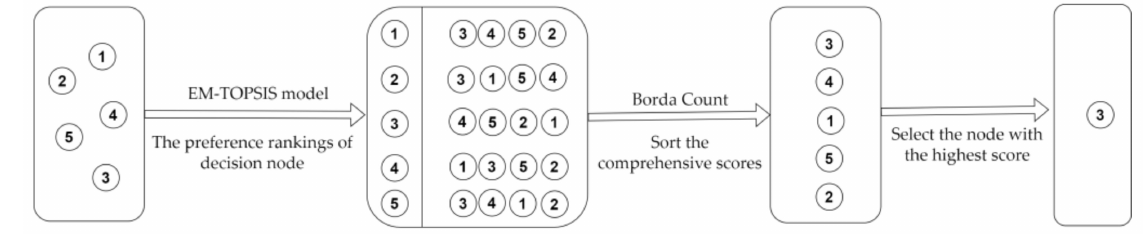
Figure 4. Primary node selection.